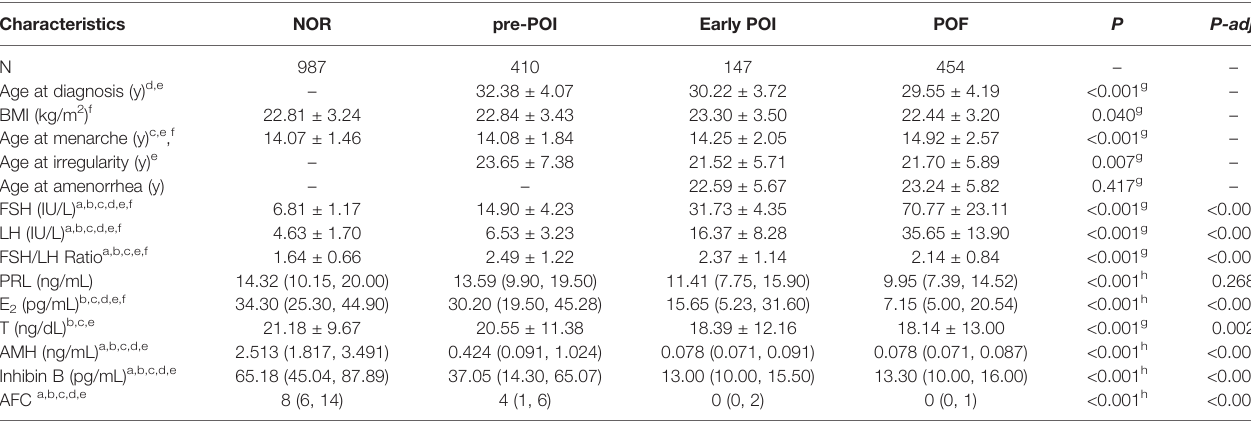
TABLE 1 | Characteristics of 1998